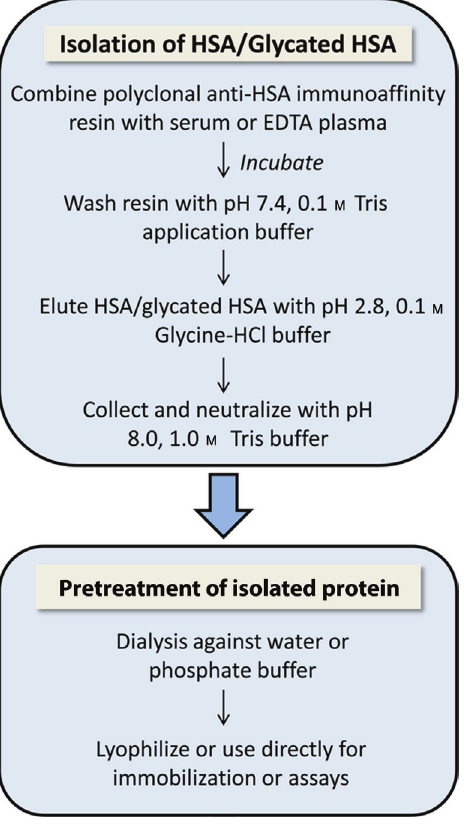
Figure 6 General scheme for the purification and isolation of in vivo glycated HSA from the serum or plasma of patients with diabetes (Anguizola et al.